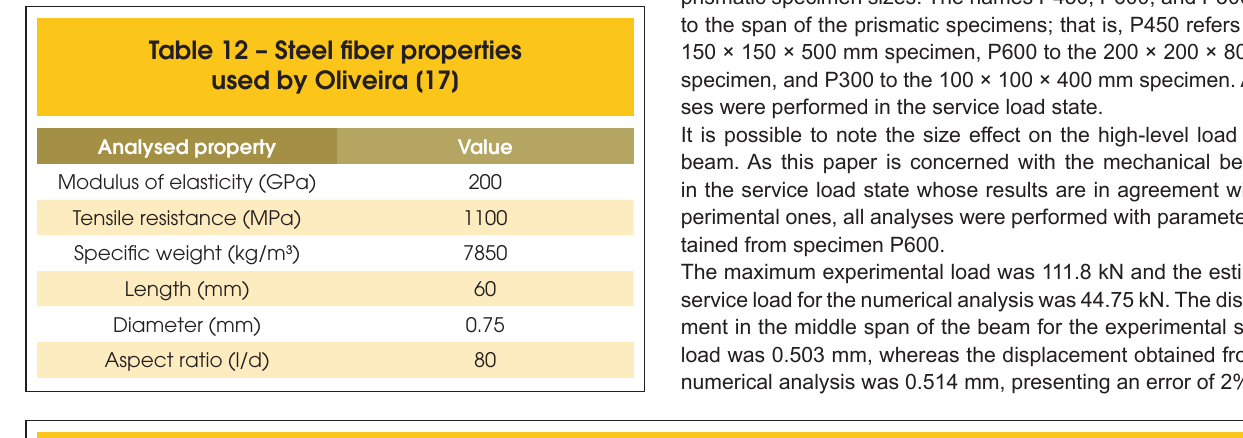
Table 13 – Mechanical properties of the concrete beams tested by Oliveira [17]